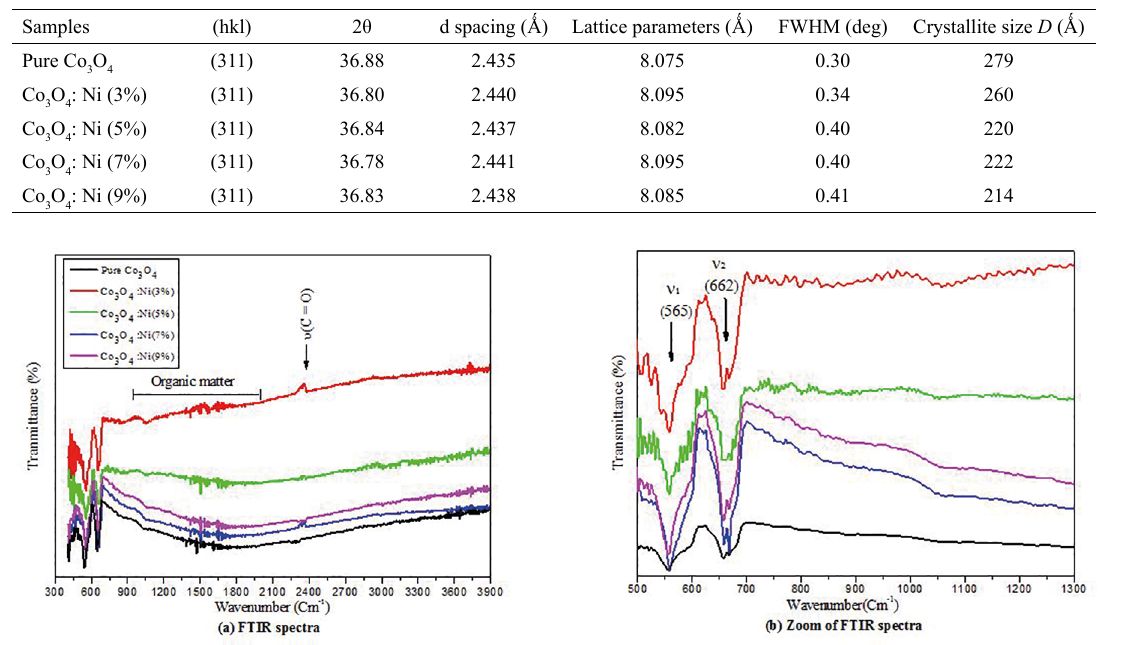
Figure 7. FT-IR spectra of pure and Ni-doped Co